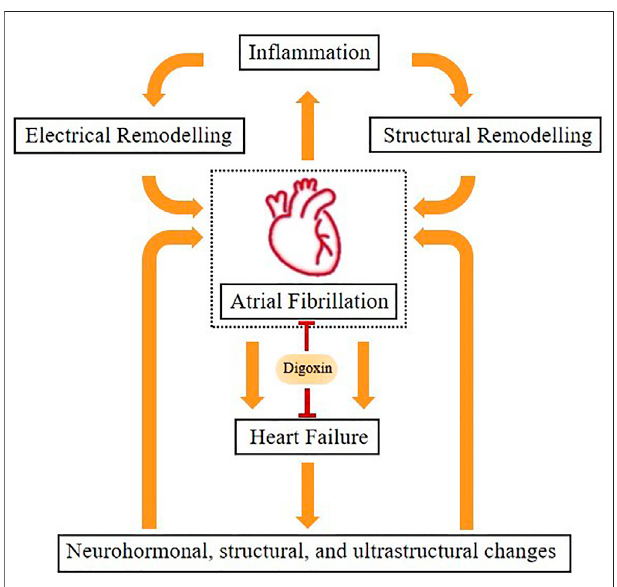
FIGURE 3 | The relationship between heart failure and atrial fi